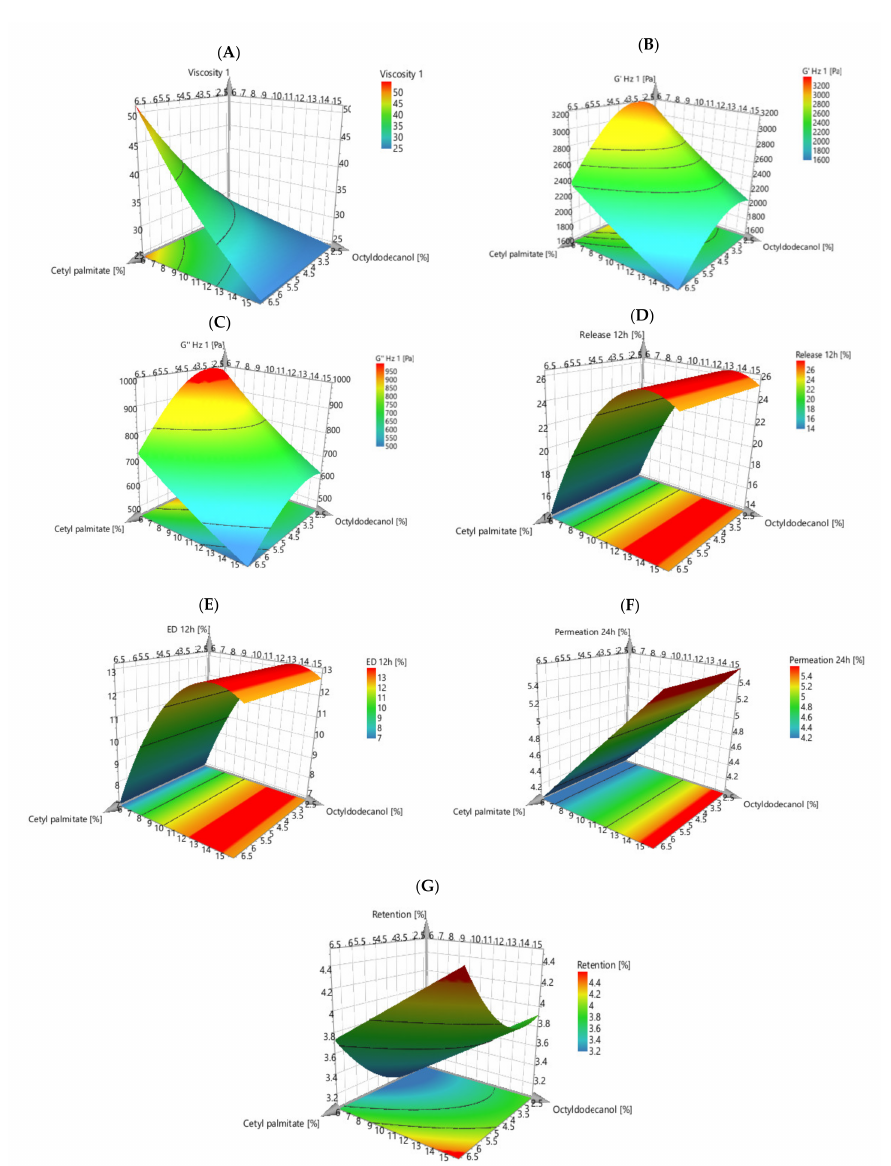
Figure 6. Response surface plots of the fitted model for viscosity ( A ), storage modulus ( B ), loss modulus ( C ), in vitro release studies ( D ), dissolution efficiency ( E ), in vitro permeation studies ( F ) and retention studies ( G